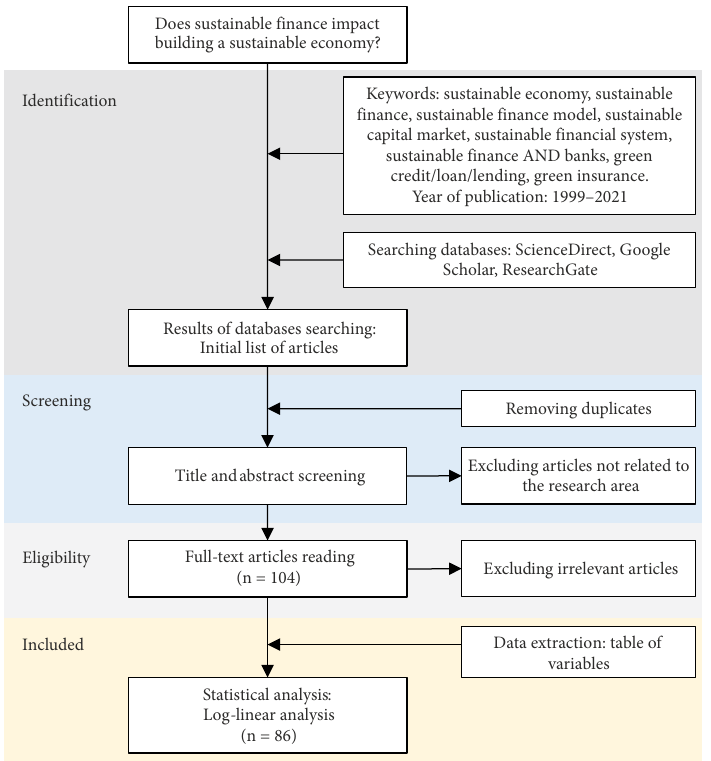
Figure 1. The flow diagram of analysis